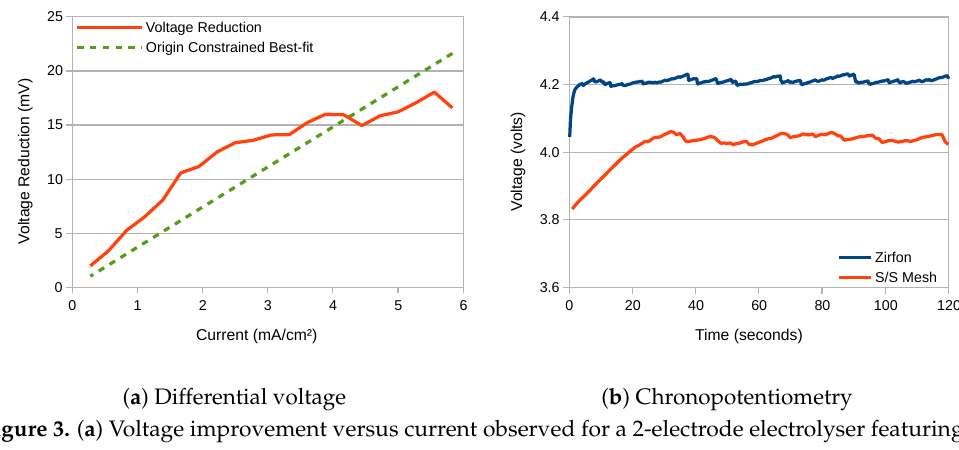
Figure 3. ( a ) Voltage improvement versus current observed for a 2-electrode electrolyser featuring a stainless-steel mesh membrane relative to Zirfon. ( b ) Voltage variation versus time for the same two membranes. Current density: 25mAcm −